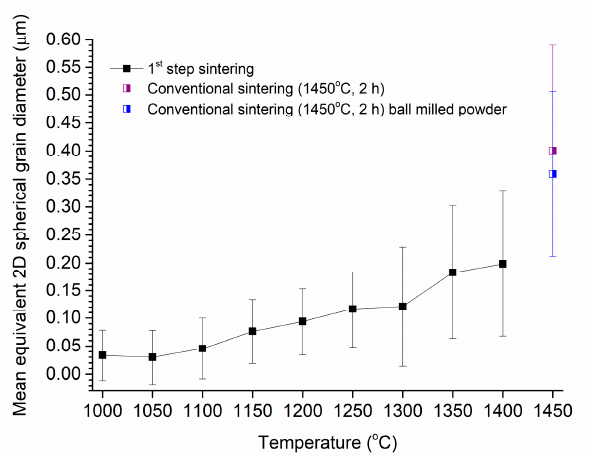
Figure 4. Mean grain size of samples after first step sintering vs. first step sintering temperature T1.